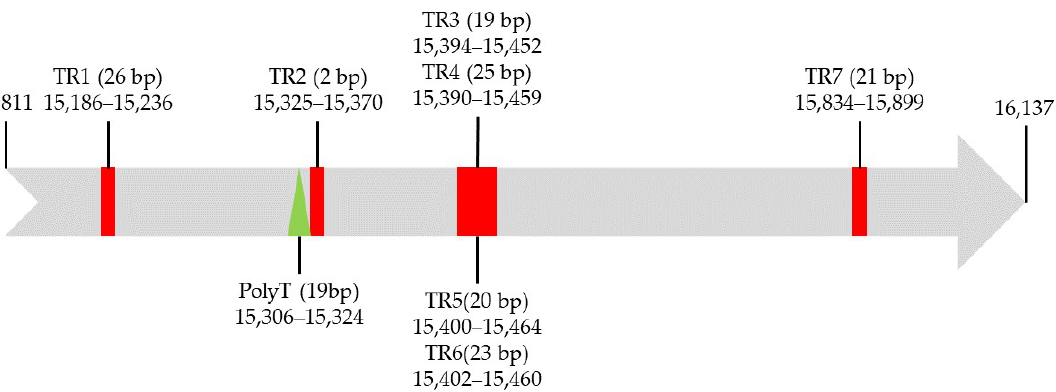
Figure 5. Organization of control region in G . orientalis mitogenome. The orange block is the tandem repeat region; the green block indicates the poly-T stretch.